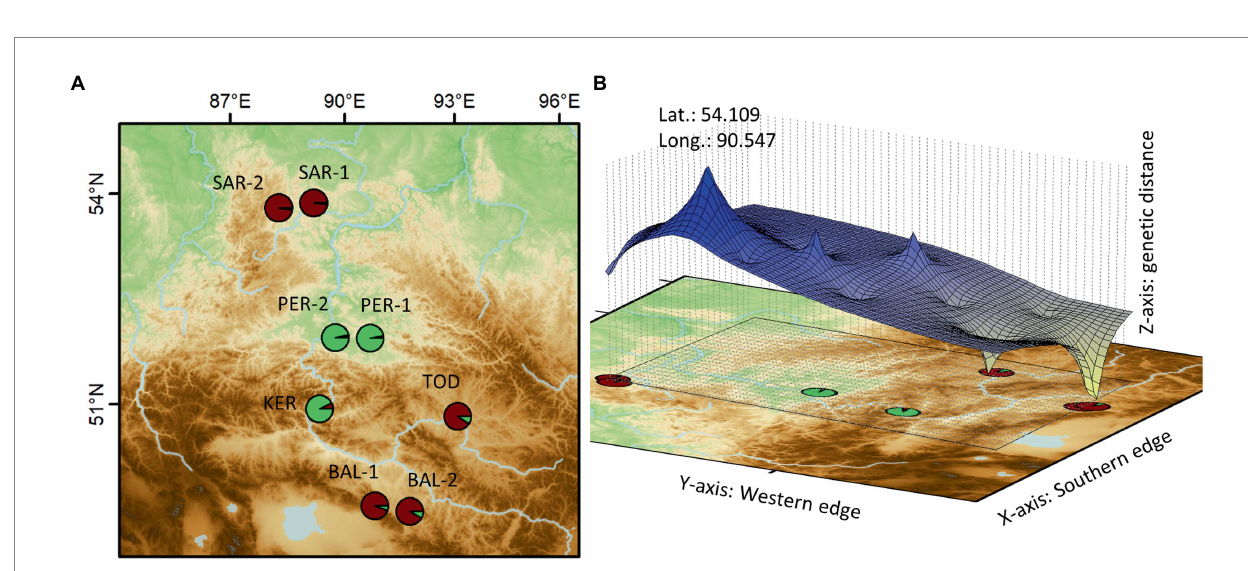
FIGURE 4 Spatial extent of the detected genetic clusters (A) and the genetic discontinuity revealed by the Genetic Landscape Shape Interpolation analysis (B) (for the acronyms, see Table